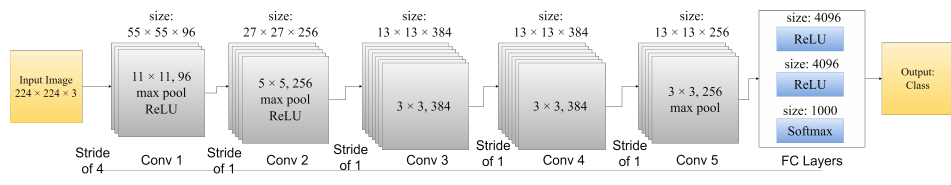
Figure 8. AlexNet